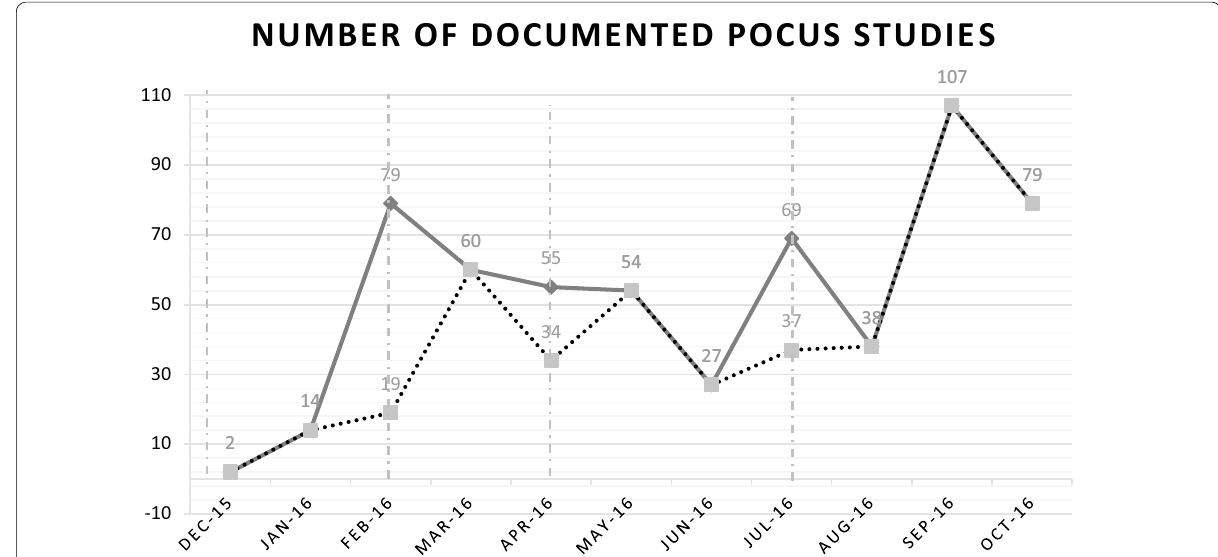
Fig. 1 Linear representation of the total number of documented POCUS studies over the study period. The vertical dashed lines are the dates of the training sessions. The dotted line is the number of unsupervised documented POCUS studies over the study period